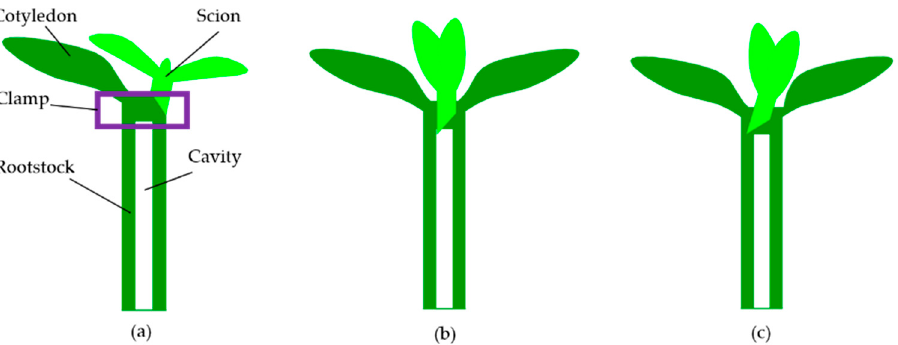
Figure 1. Grafting methods of melon vegetables: ( a ) Splice grafting method; ( b ) Straight inserted grafting method; ( c ) Inclined inserted grafting method.